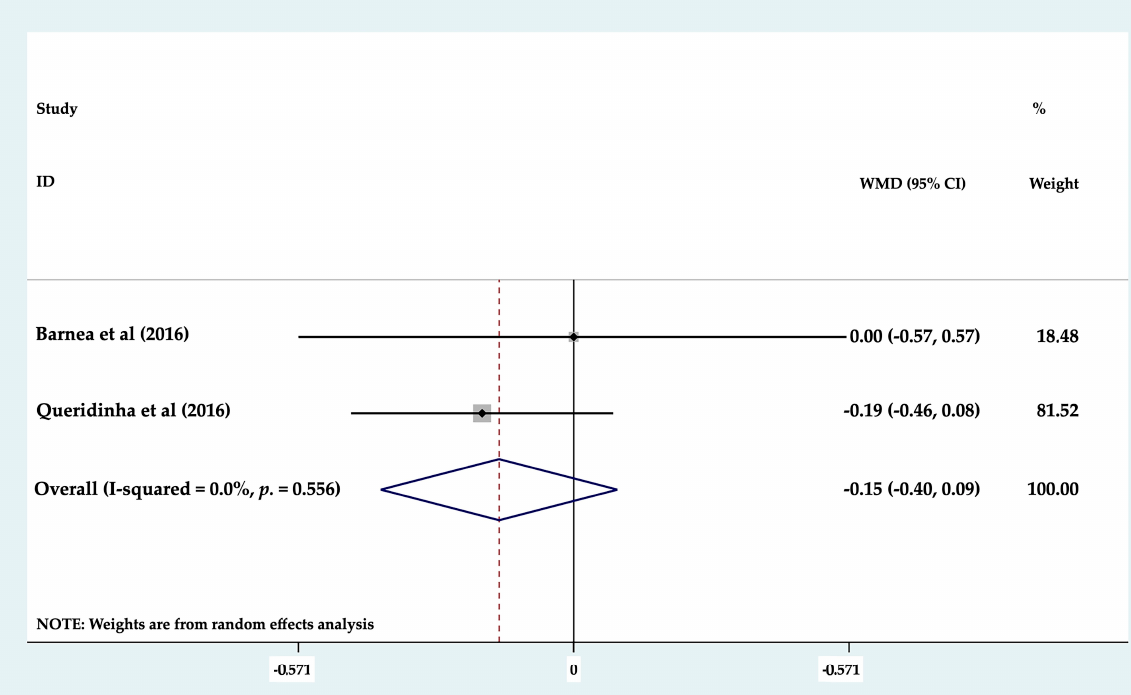
Figure 3. Forest plot of marginal bone loss in partial arch restorations. No statistically significant differences ( p ≥ 0.05) were found.